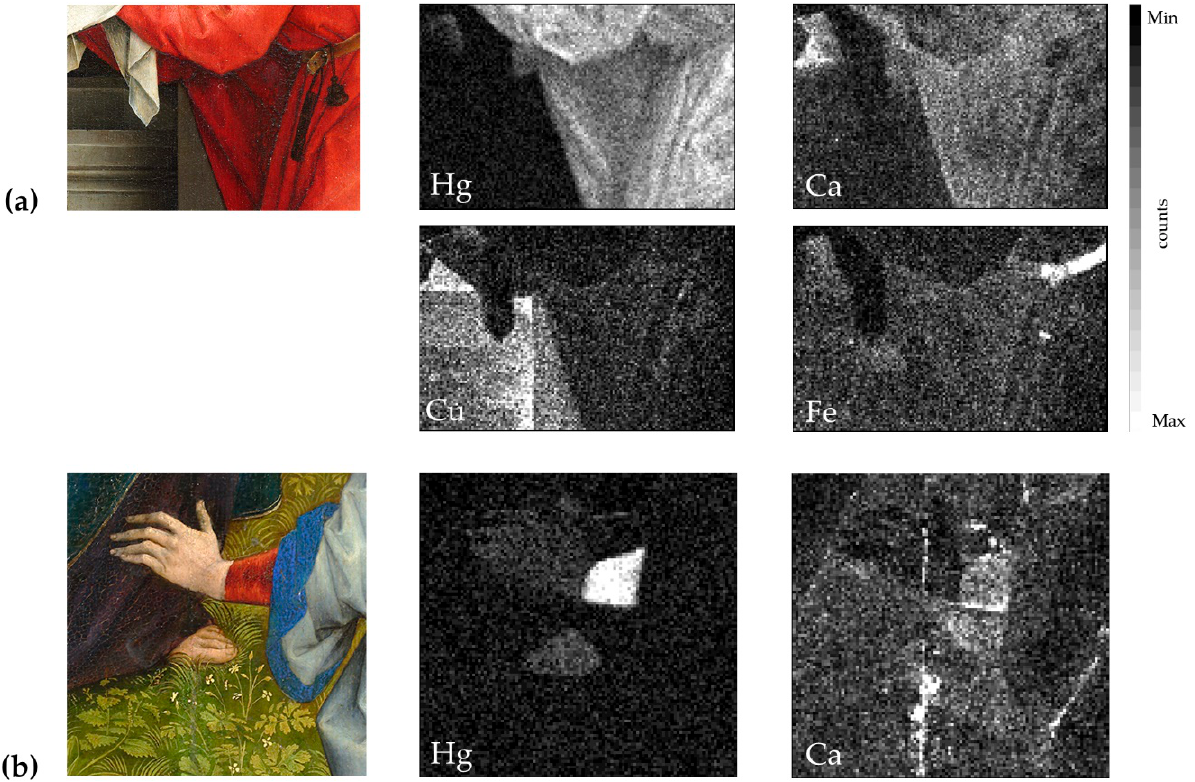
Figure 4. ( a ) Detail of the red robe of John the Evangelist, with relative Hg(L α ), Ca(K α ), Cu(K α ), and Fe(K α ) XRF maps; ( b ) detail of the red sleeve of Magdalene, with relative Hg(L α ) and Ca(K α ) XRF maps.